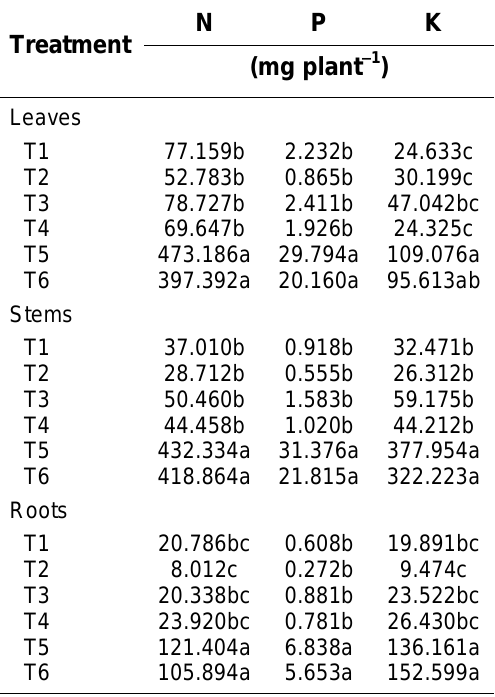
Effect of Different Treatments on Uptake of N, P, and K in Leaves, Stems, and Roots of Maize Plants at 57 DAS